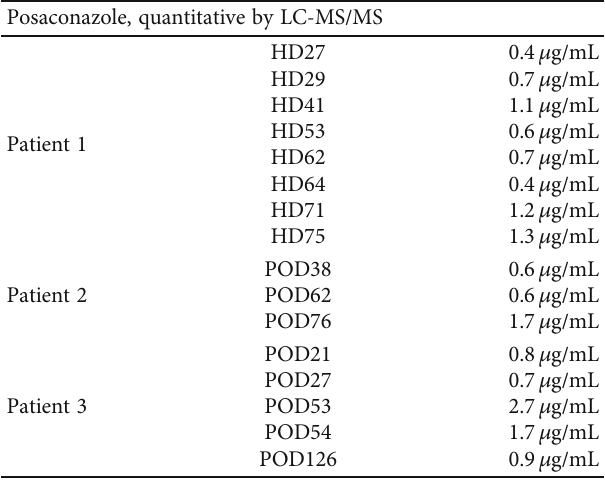
Table 3: Therapeutic drug monitoring results of